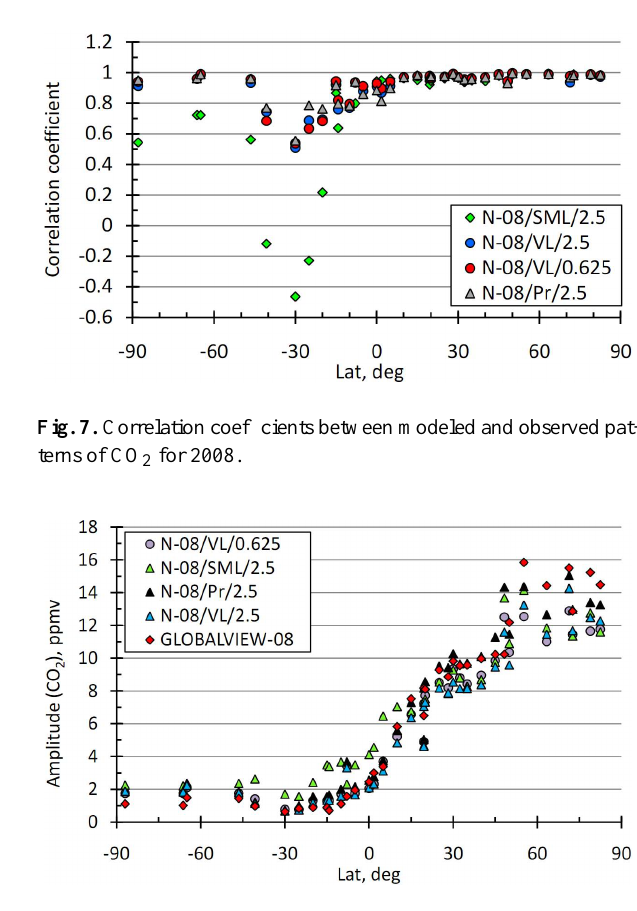
Fig. 8. Amplitude of CO 2 seasonal variations for January 2008